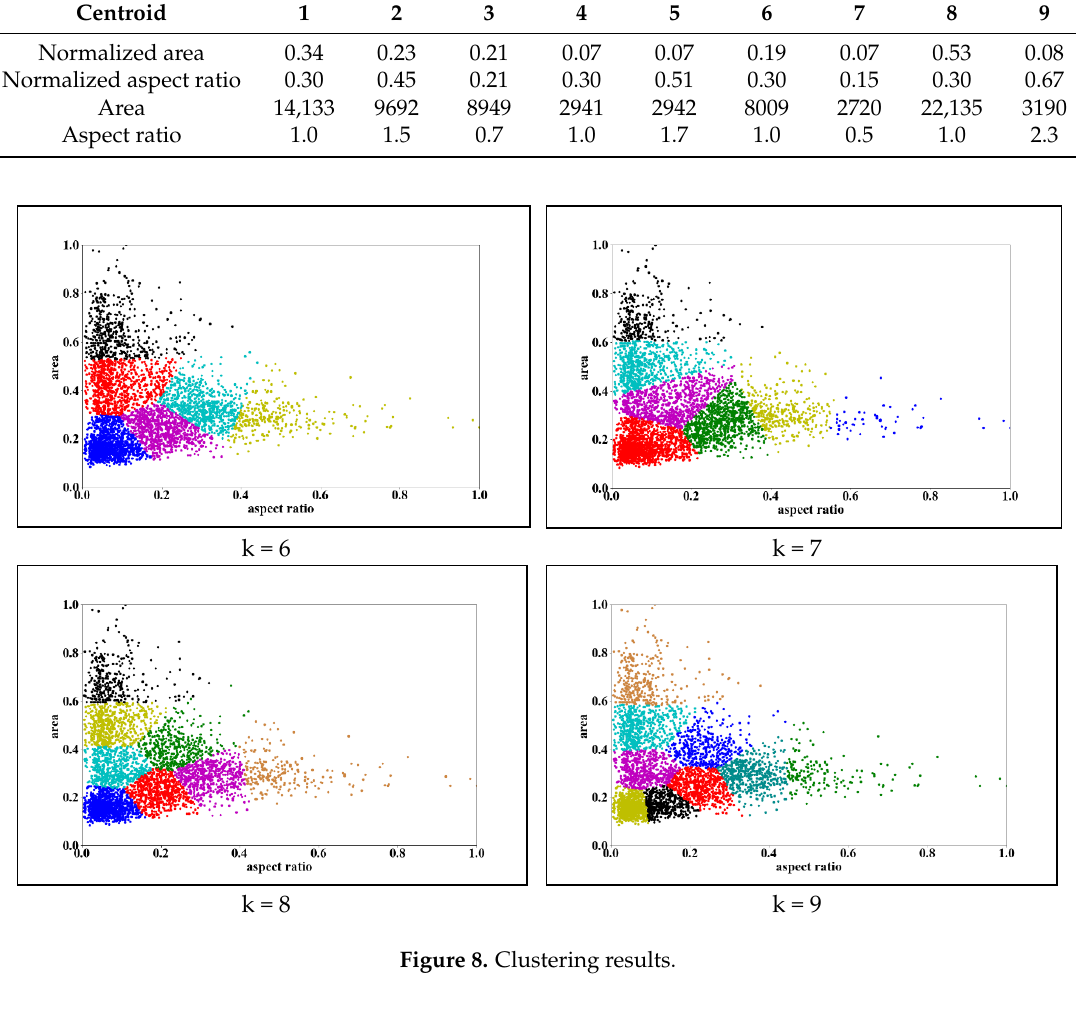
Figure 8. Clustering results.